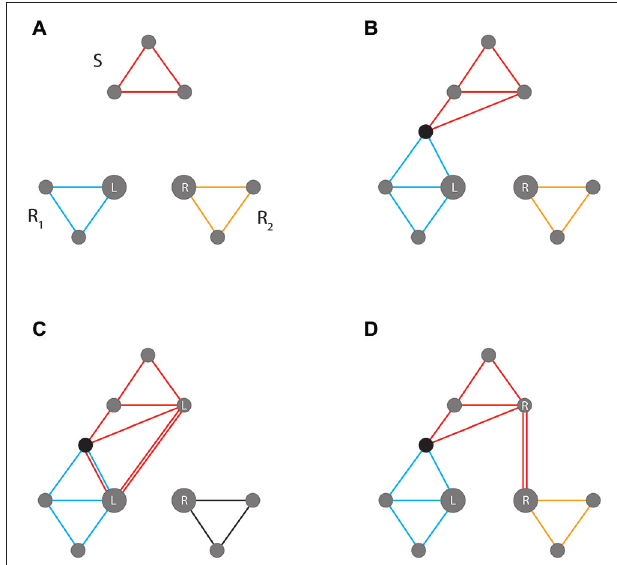
FIGURE 4 | Event code assemblies involved in the Simon task. (A/B) Control condition (where stimulus location is constant across trials) (A) Initial assembly of non-intersecting stimulus and response codes (stimulus code S and two competing response codes, R 1 and R 2 , with location features L/R highlighted). (B) New overlap between S and R 1 instantiates the required mapping. (C,D) Interference condition (where stimulus location varies across trials) (C) Compatible trial; stimulus location (L) supports the required response. (D) Incompatible trial; stimulus location (R) supports the opposite response. See text for further